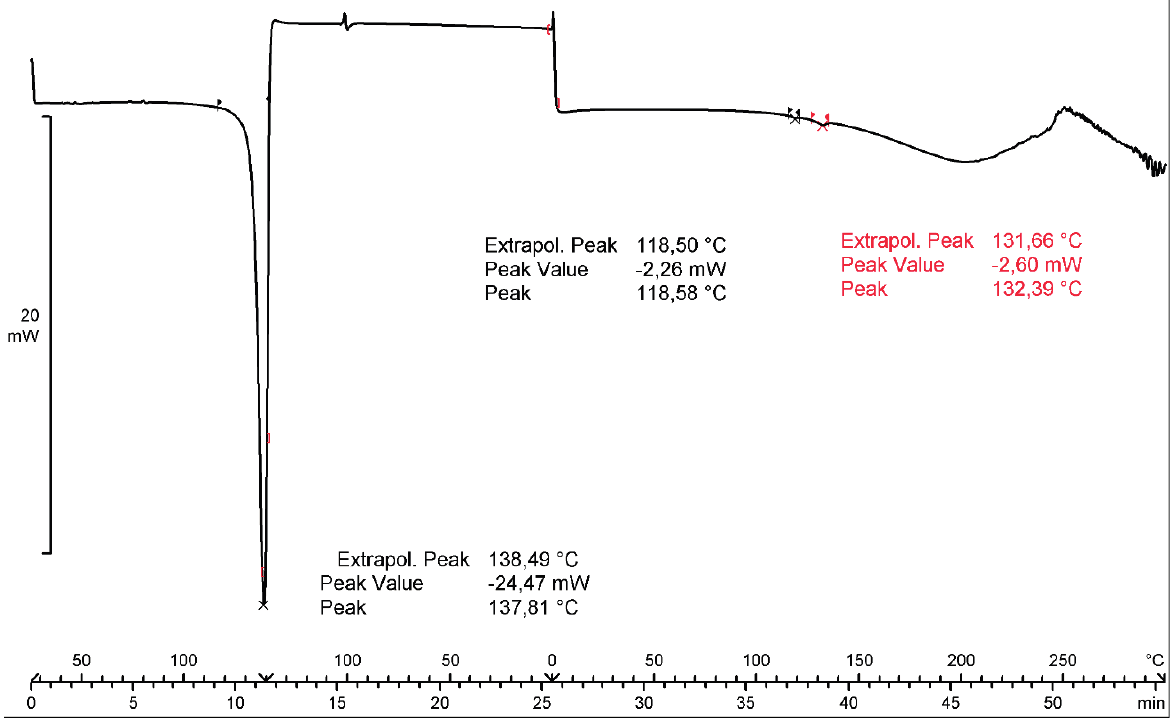
Figure 4. DSC temperature loop of pemetrexed diacid form 1